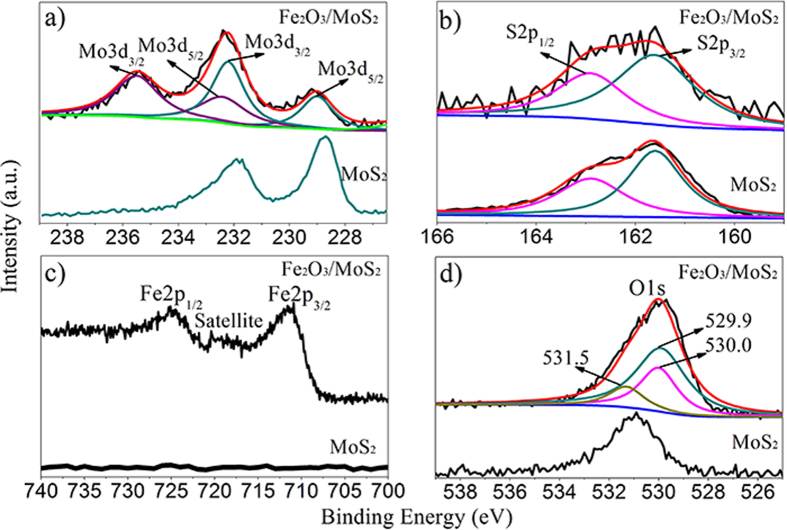
XPS spectra of Fe2O3/MoS2 composite and MoS2 nanosheets.(a) Mo 3d XPS spectrum, (b) S 2p XPS spectra, (c) Fe 2 P XPS spectrum, and (d) O 1 s XPS spectrum.